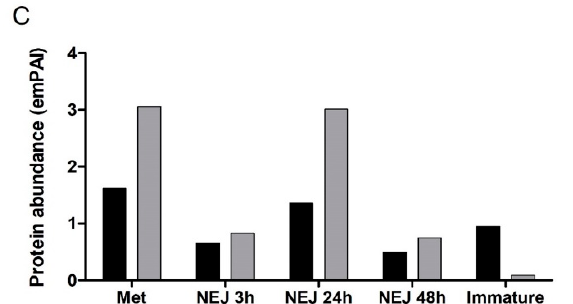
Figure 2. Expression profile of FhSOD1 and FhSOD3 throughout the F. hepatica life cycle within the mammalian host. ( A ) Graphical representation of the stage-specific transcription of the FhSOD1 and FhSOD3 genes displayed as transcripts per million (TPM) extrapolated from the transcriptome study of the metacercariae (Met), newly excysted juveniles at 1, 3, and 24 h post-excystment (NEJ 1 h, NEJ 3 h, NEJ 24 h), immature and adult liver flukes by Cwiklinski et al. [5]. ( B ) Graphical representation of the FhSOD1 and FhSOD3 proteins secreted within the ES protein fraction by the NEJ, immature, and adult parasites, represented by the exponentially modified protein abundance index (emPAI). The adult secretome data are displayed as the EV-depleted fraction (Adult_ES), and the microvesicle (Adult_15K) and exosome (Adult_120K) sub-fractions of the EV component recovered following centrifugation at 15,000× g and 120,000× g , respectively. ( C ) Graphical representation of the FhSOD1 and FhSOD3 protein abundance within the somatic proteome of the metacercariae (Met); newly excysted juvenile (NEJ) 3, 24, and 48 h post-excystment (NEJ 3 h; NEJ 24 h; NEJ 48 h); and immature liver flukes. The proteomic data for the NEJ, immature, and adult parasites are ex-